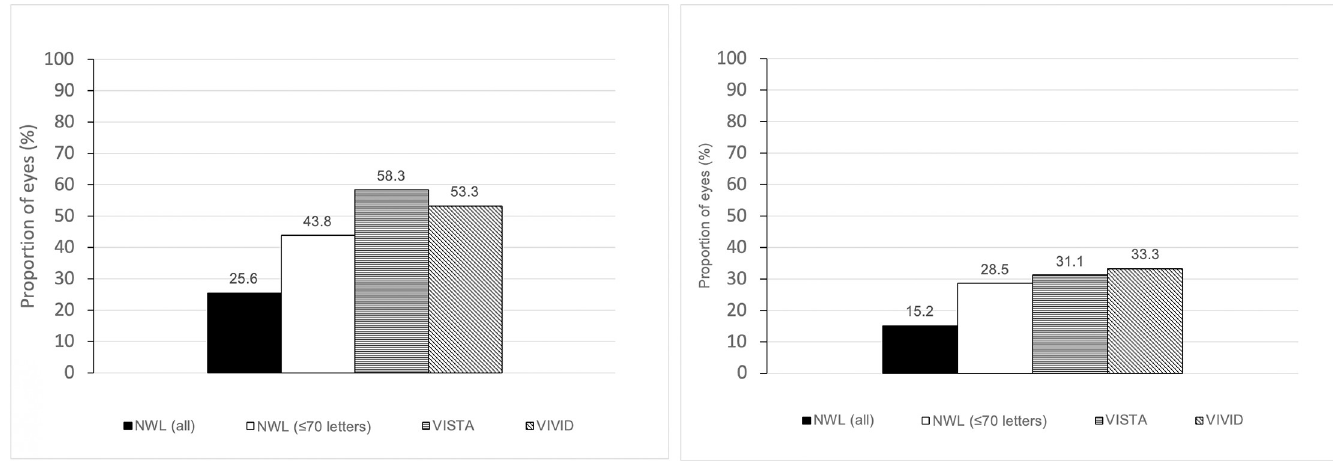
PLOS ONE | https://doi.org/10.1371/journal.pone.0246626 February 11,